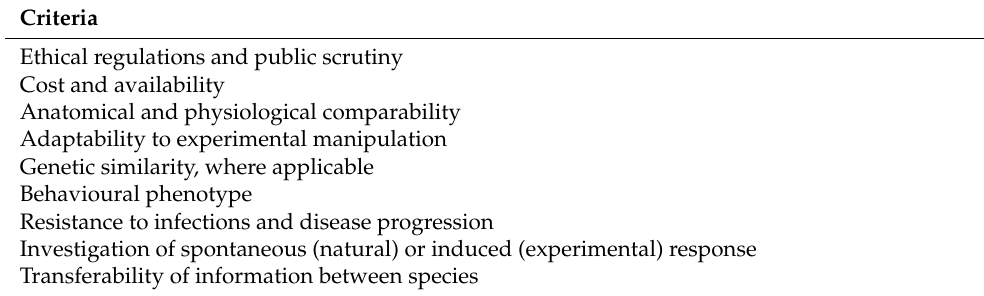
Table 1. Criteria for choosing the most appropriate animal model. Summarised from refs